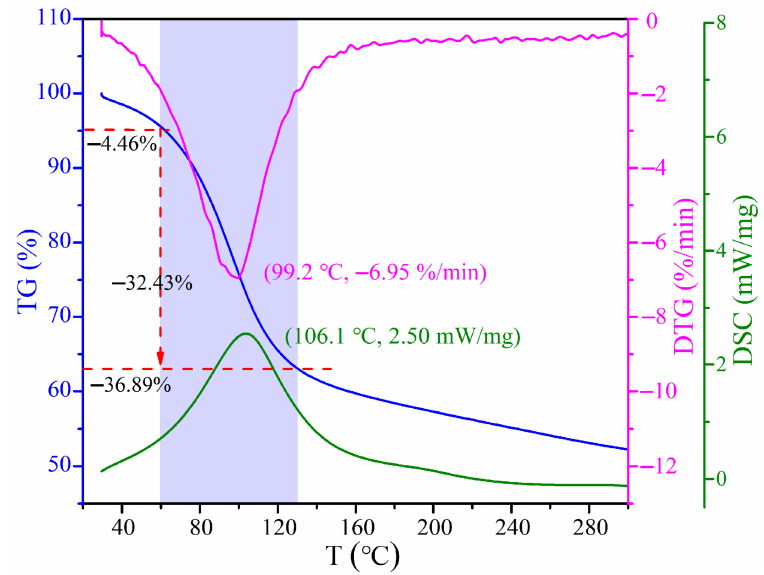
Figure 6. TG-DTG-DSC curves of CRES in air.